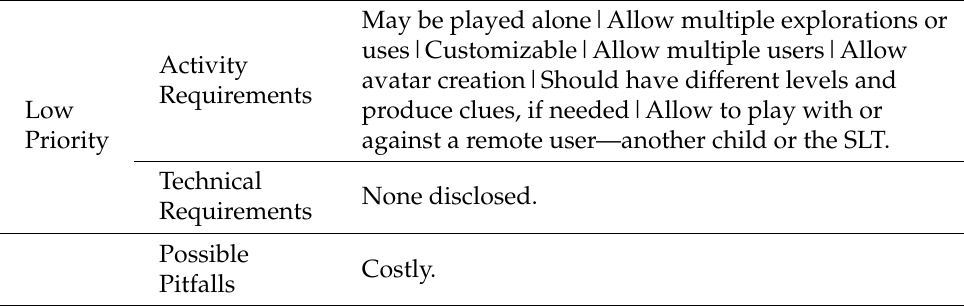
Table 3. Low priority requirements as well as identified